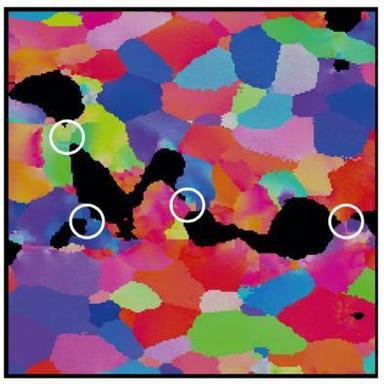
A slice of the dataset showing multiple intervoid regions with void extensions, here tending to lie along grain boundaries. The misorientation in these regions suggest a high degree of plastic deformation.